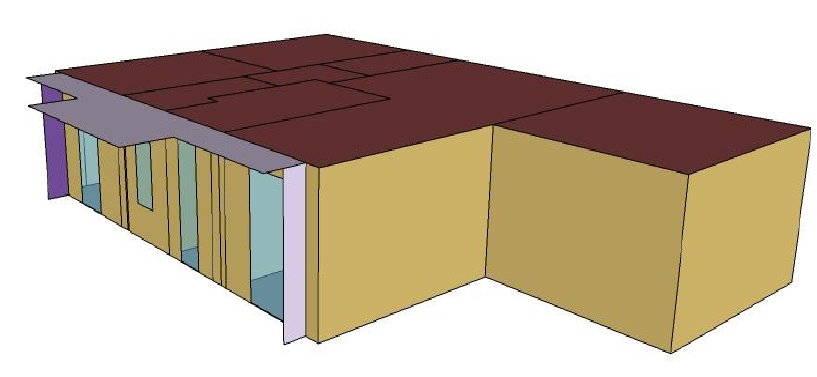
Figure 9. Three-dimensional model of the flat without the